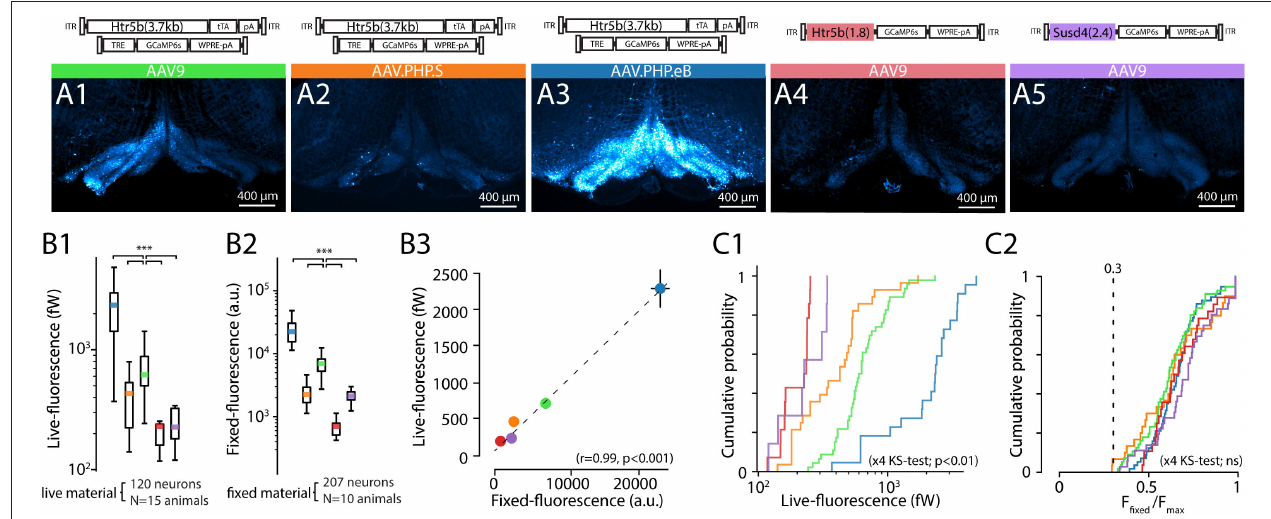
FIGURE 4 | Comparison of tissue-fixed and live-imaging GCaMP6s fluorescence intensities in-vitro . (A1–A5) Example confocal images (5x) demonstrating wide-area GCaMP6s fluorescence obtained with 5 different constructs (as indicated above each) after 2 weeks of expression. Images are acquired from 300 µ m brainstem slices, immersion-fixed after live in-vitro imaging experiments. (B) Comparison of the constructs’ baseline (F 0 ) whole-field live fluorescence measurements for individual neurons (B1) and confocal imaging (B2) before (B1) and after (B2) immersion-fixing. (B3) shows the high correlation between the live imaging and confocal imaging results. Colored dots are average values for each construct, where 10 to 20 neurons per slice for the live, and fixed condition in the same slices. (n = 3 slices per animal, min. 2 animals per construct). (C) Distribution of raw live-imaging fluorescence intensities varies between constructs (C1) , but the relative ranges are nearly identical when normalized to maximal intensity in each slice (C2) . Dashed line in (C2) indicates relative intensity of 0.3. For (B,C) , data from different constructs are labeled with colors as in (A)